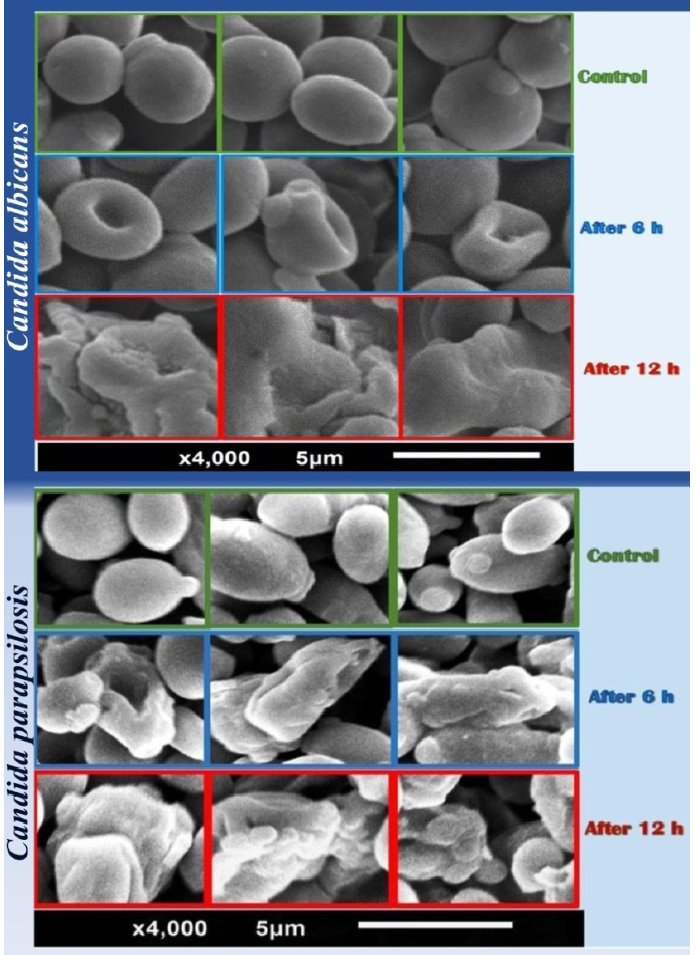
Figure 1. SEM images of un-treated and treated Candida albicans (ATCC 10231) and Candida para- psilosis (MH 445556) with n -hexane extract of S. costus after exposure for 6 h and 12